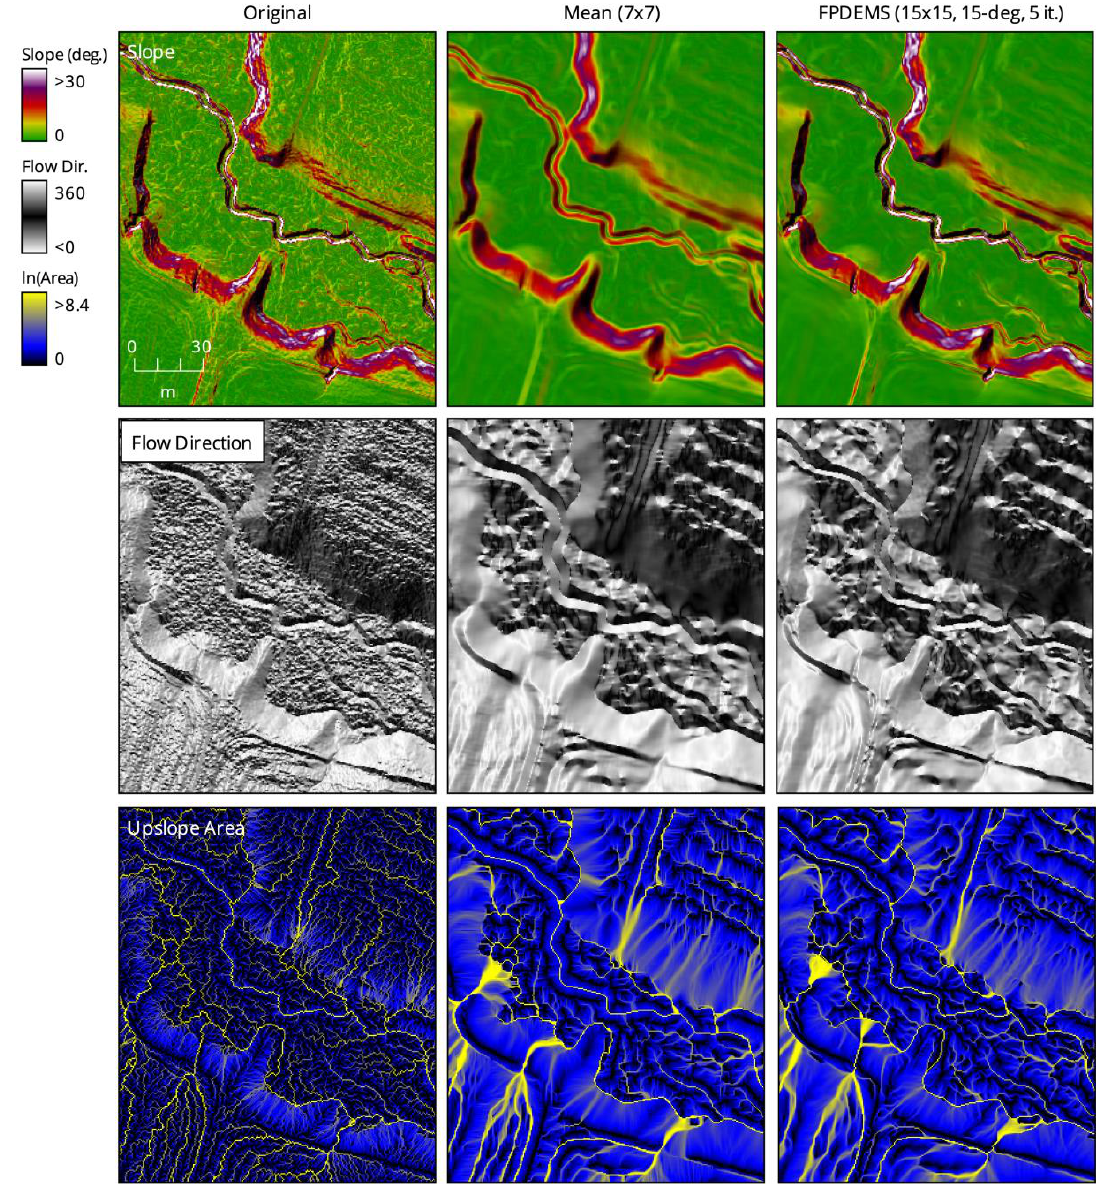
Figure 11. The spatial distribution of slope gradient, D ∞ flow direction, and D ∞ upslope area for the same portion of the study site shown in Figure 10. These flow-path terrain attributes are shown for the original DEM (left column), the 7 × 7 mean treated DEM (center column), and the FPDEMS (15 × 15 filter size / 15 ◦ normal di ff erence threshold angle / 5 iterations) treated DEM (right column).